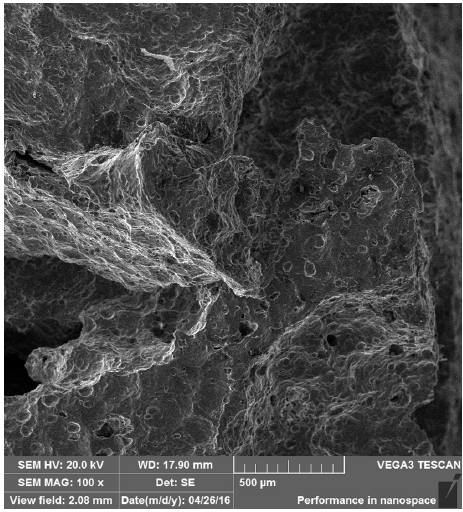
Figure 10. Failure of as-received foam at room temperature.